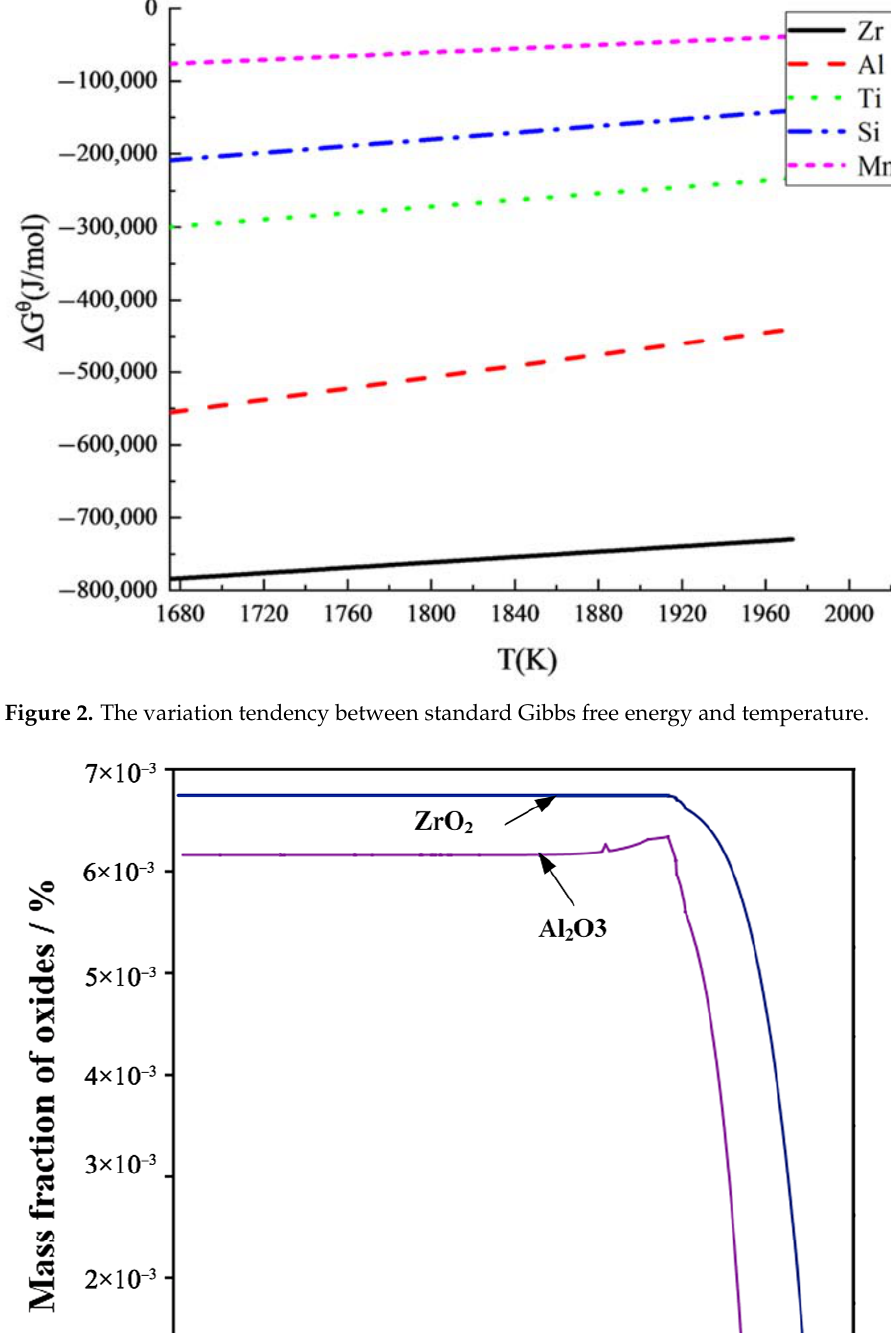
Figure 3. Mass fractions of oxide calculated by ThermalCalc for the Al ‐ Steel and Zr ‐ Steel.